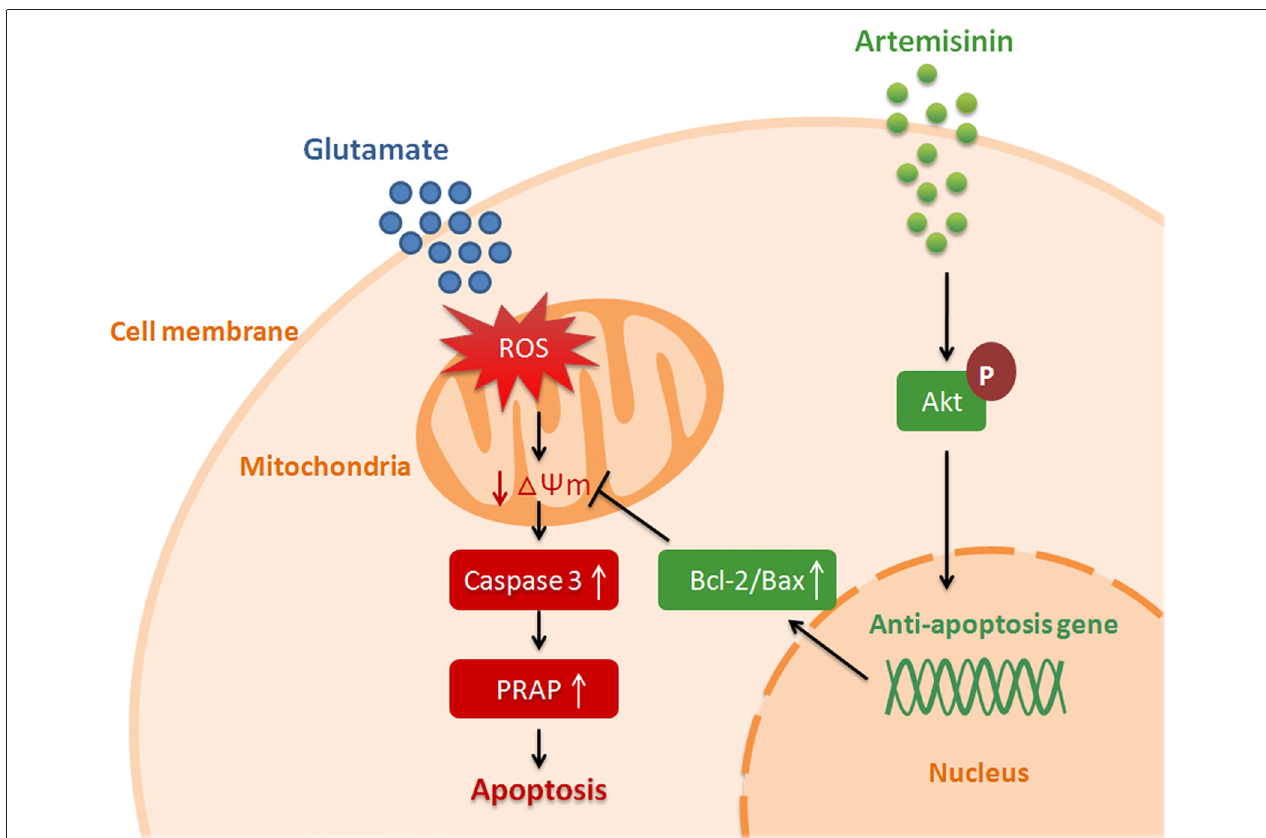
FIGURE 7 | Hypothetical model of artemisinin mediated neuroprotection against glutamate-induced oxidative stress injury.